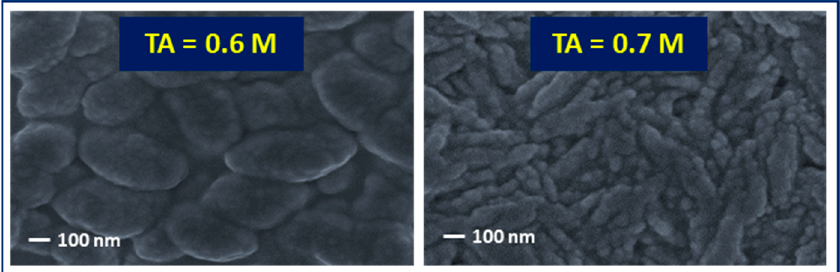
Figure 5 . SEM surface images of both SnS and SnS 2 films deposited at thioacetamide (TA) concentrations of 0.6 and 0.7 M, respectively.